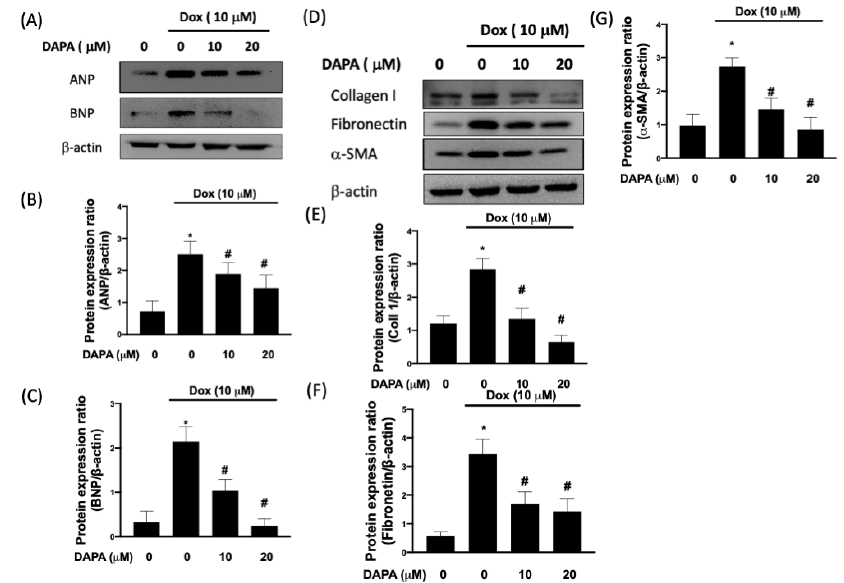
Figure 5. DAPA mitigates the expression of cardiac fibrosis markers in Dox-stimulated cells. Repre- sentative Western blot images ( A ) and densitometric analysis of ANP ( B ) and BNP ( C ) in Dox-treated H9c2 cells with various concentrations of DAPA treatment were shown. Representative Western blot images ( D ), densitometric analysis collagen I ( E ), fibronectin ( F ), and α -SMA ( G ) in Dox-treated H9c2 cells with various concentrations of DAPA treatment were disclosed. Results are shown as means ± SD of three independent experiments. Statistical analysis was performed using one-way ANOVA with a Bonferroni post hoc test. [* p < 0.05 compared to the control group; # p < 0.05 compared to the Dox-only group; & p < 0.05 compared to Dox + DAPA group].